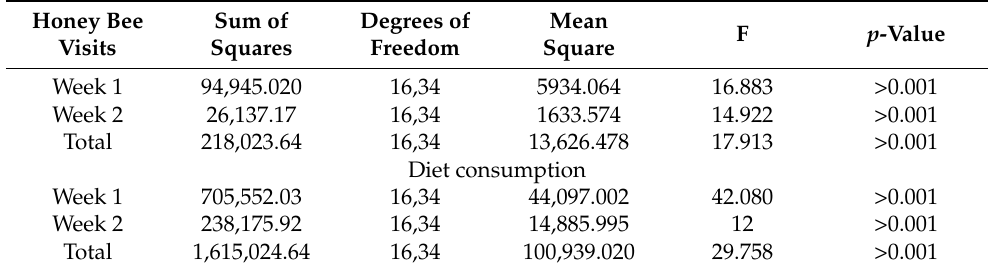
Table 2. Honey bee visit and diet consumption (ANOVA).